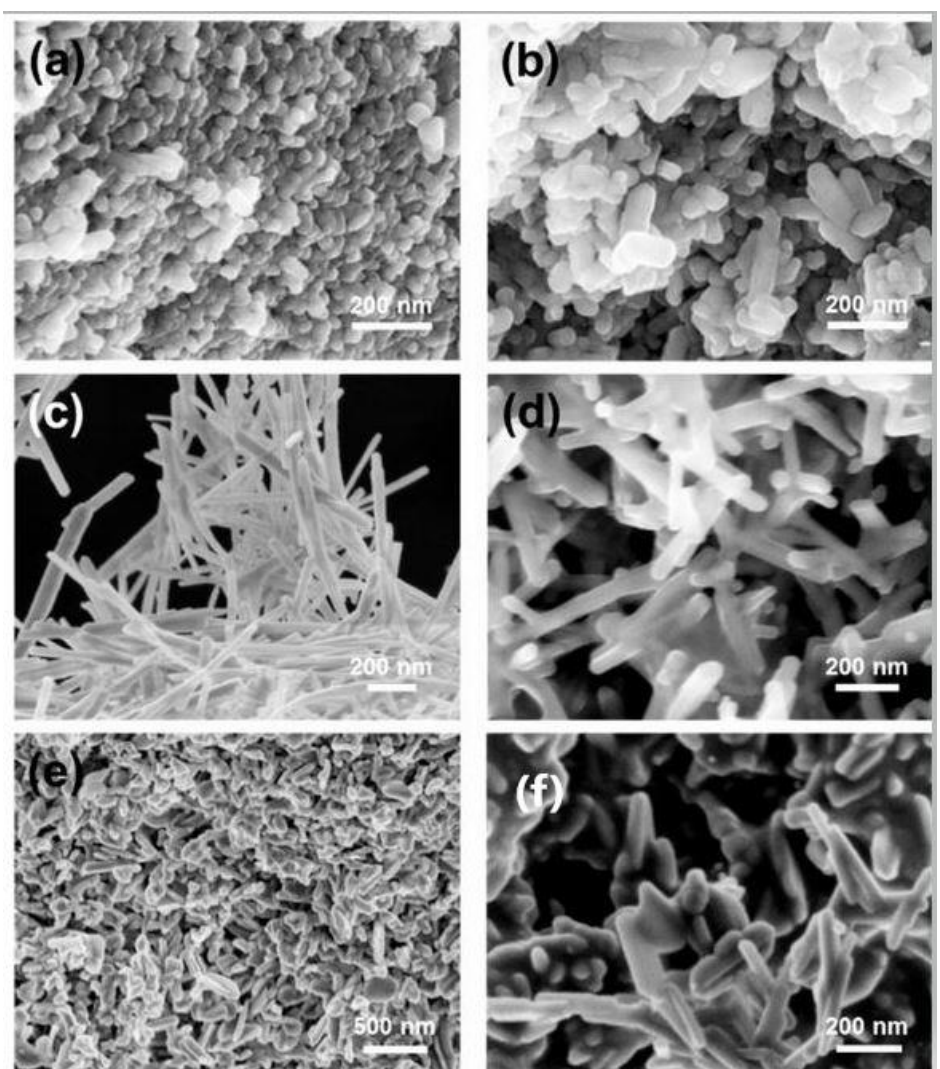
Figure 2. SEM images of hydroxyapatite nanoparticles with different morphologies, obtained from the methods proposed by Sans et al. [5]: ( a ) spherical polymorphs; ( b ) rod shapes; ( c ) belts; ( d ) belts with smaller aspect ratios; ( e ) low magnification of needle-flakes; ( f ) high magnification of needle-flakes. Reprinted with permission from Jordi Sans, Vanesa Sanz, Jordi Puiggalí, Pau Turon and Carlos Alemán, Controlled Anisotropic Growth of Hydroxyapatite by Additive-Free Hydrother- mal Synthesis, Cryst. Growth Des. 2021, 21, 2, 748–756. Copyright (2020) American Chemical Soci-